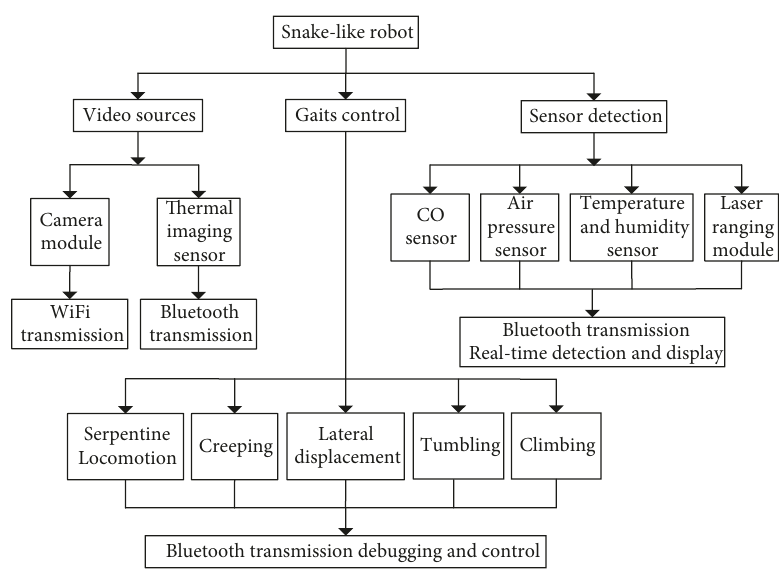
Figure 9: Logic diagram of the monitoring